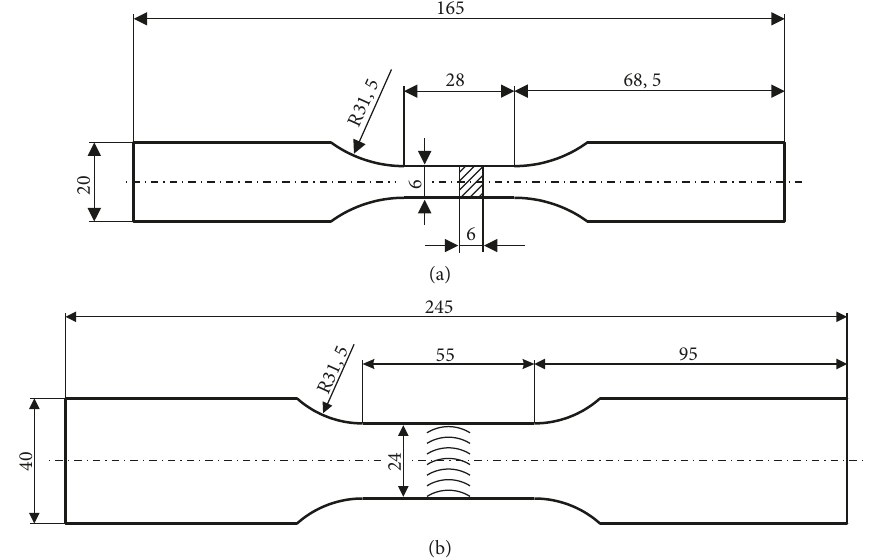
Figure 2: Dimensions of samples used in fatigue tests conducted on the paternal material (a) and welded joints